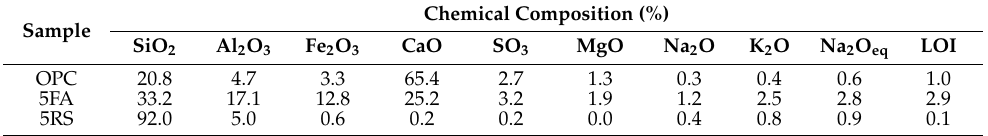
Table 1. Chemical compositions of ordinary Portland cement (OPC), 5FA, and 5RS.